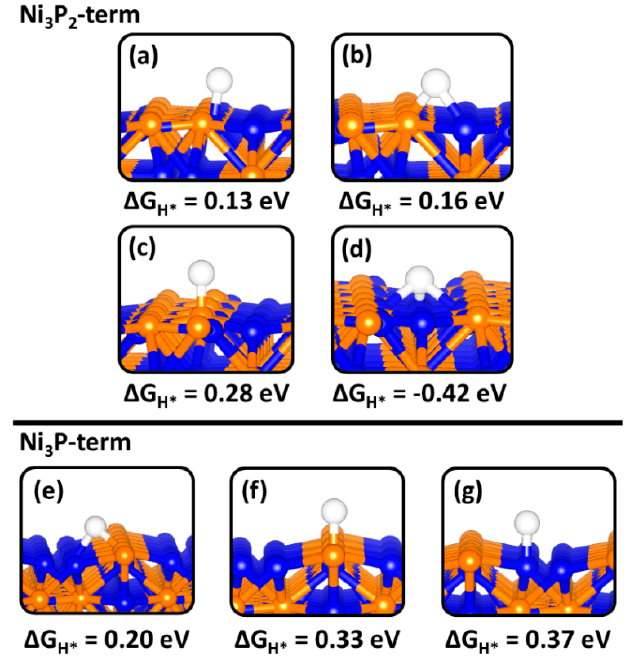
Figure 7. Gibbs free of hydrogen adsorption ( Δ G H* ) at different binding sites on the (0001) surface of Ni 2 P. Whereby ( a – d ) represent Ni-top, Ni-P-bridge, P-top and 3-Ni-bridge, respectively on the Ni 3 P 2 -termination. Along with ( e – g ) showing a Ni-P-bridge, P-top and Ni-top respectively on the Ni 3 P-termination.